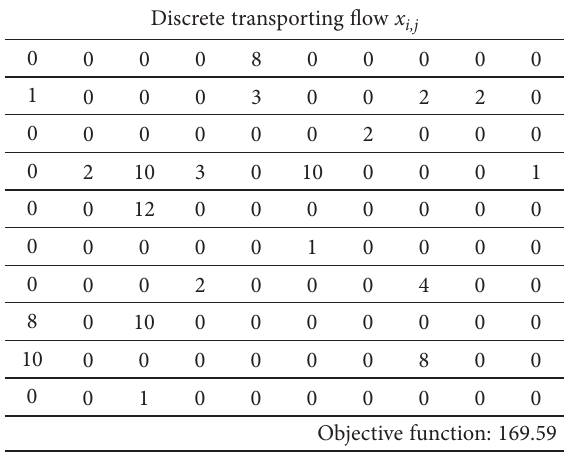
Table 5. Best obtained discrete solution for the 10×10 test